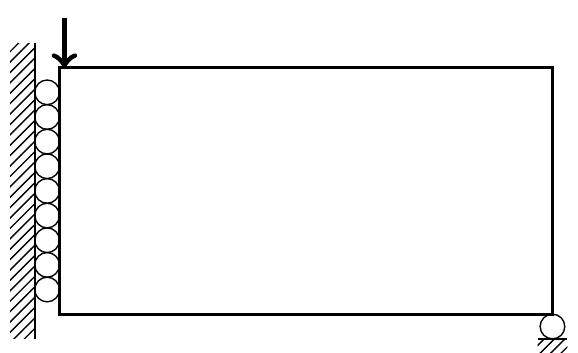
Figure 4. Conditions for MBB Beam.